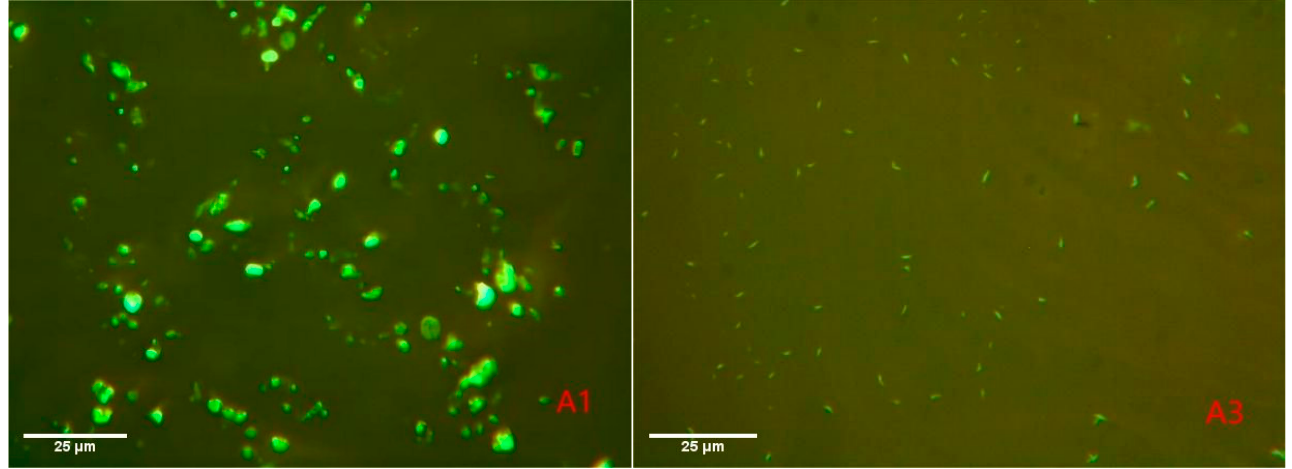
Figure 10. Fluorescence images of different modified asphalts.